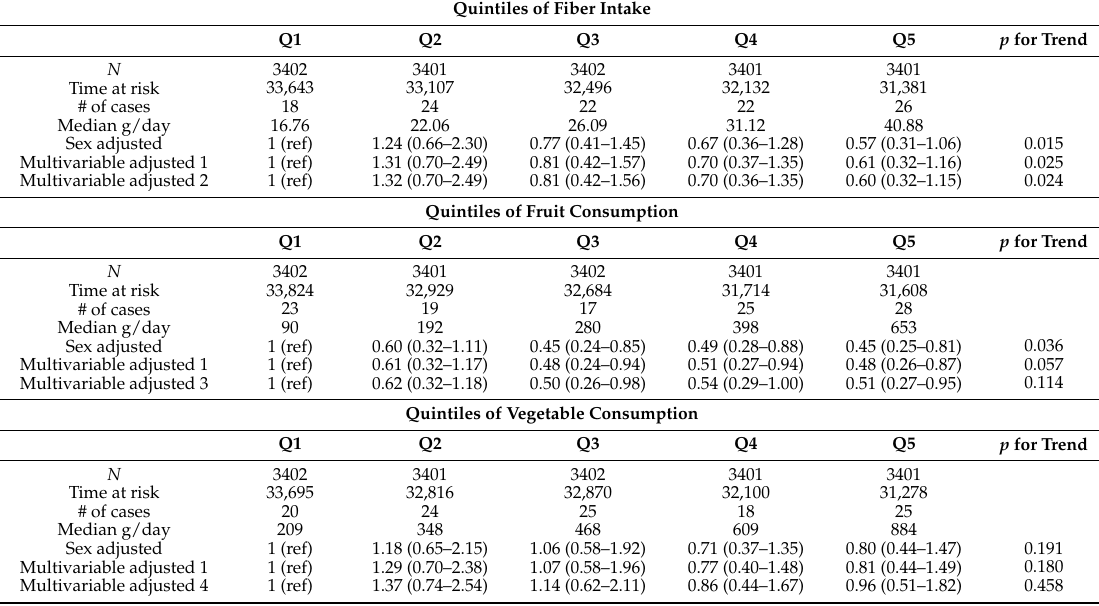
Table 3. Hazard ratios (HRs) (95% confidence intervals) of cardiovascular disease (CVD) according to baseline quintiles (Q) of fiber, fruit, vegetables, pulses, or whole-grain